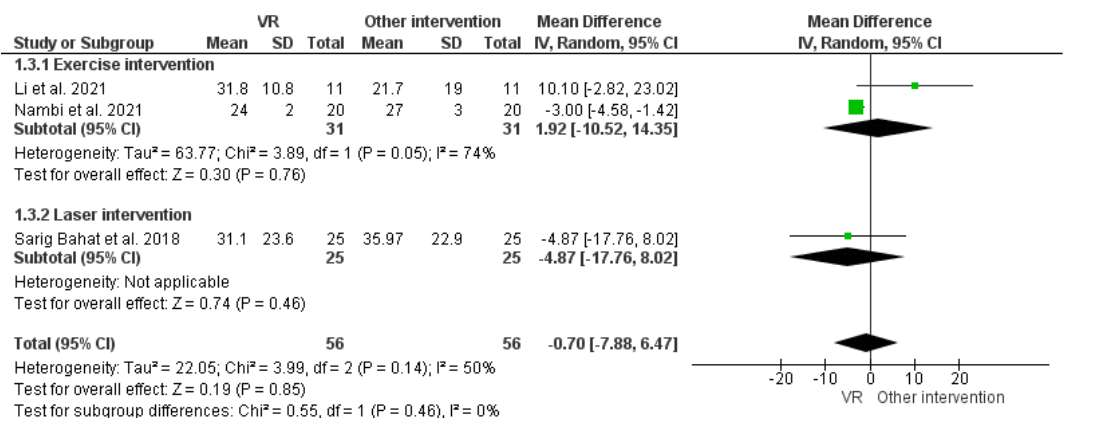
Figure 4. Effect of VR and other interventions on VAS improvement. Green squares represent mean difference for each study, while black rhombus represents the aggregated average of the mean differences.